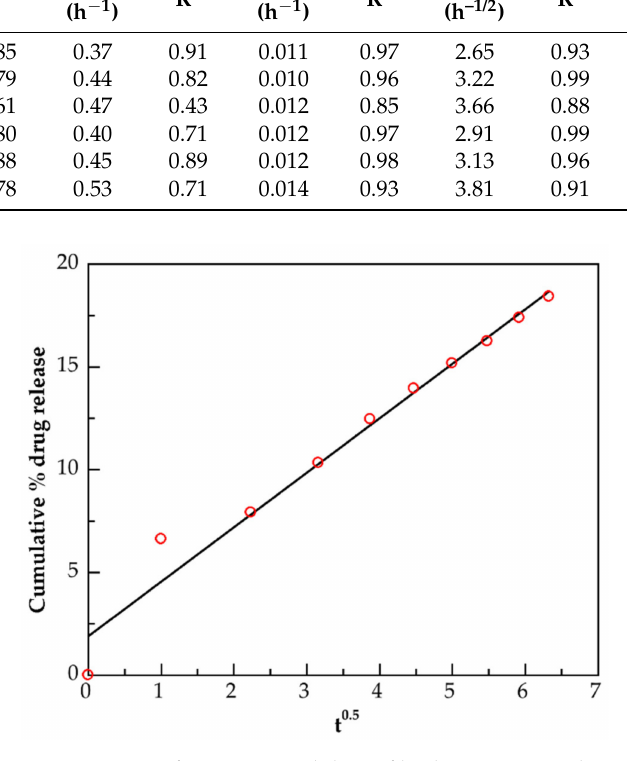
) with Higuchi model (cid:35)